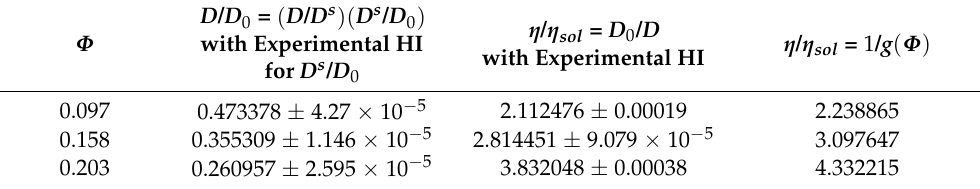
Table 1. Maghemite ferrofluid at T = 298 K , using experimental data from Meriguet, G. et al. [4] for S ( k ) and its fit with RMSA given in Figure 5. From the low to high Φ , the parameters in potential Equation (4) are ( γ (cid:48) , κ (cid:48) ) = ( 9.9307, 42060.621 ) , ( 9.1645, 27454.6523 ) , and ( 9.0739,33659.3519 ) . D / D 0 = ( D / D s )( D s / D 0 ) η / η sol = D 0 / D with Experimental HI Φ with Experimental for D s / D 0